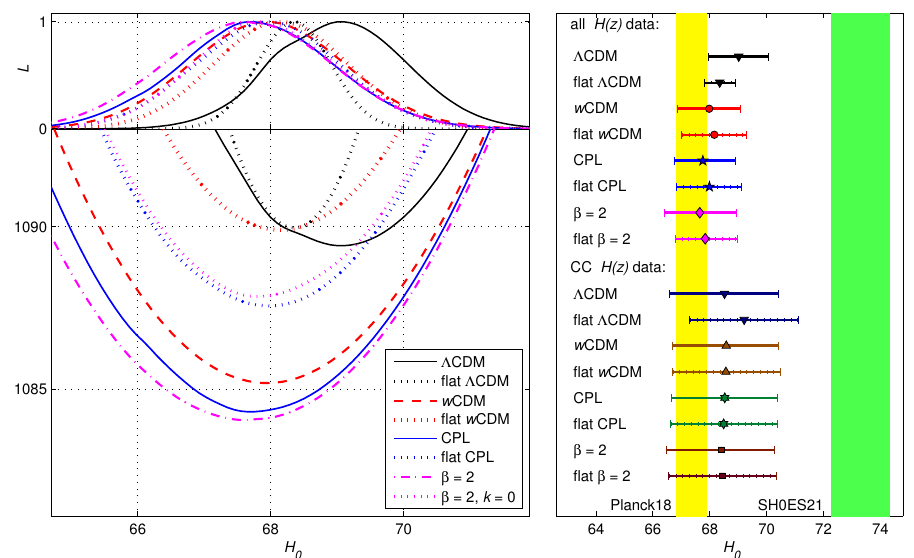
( H ) and likelihood functions for models with all H ( z ) 0 tot